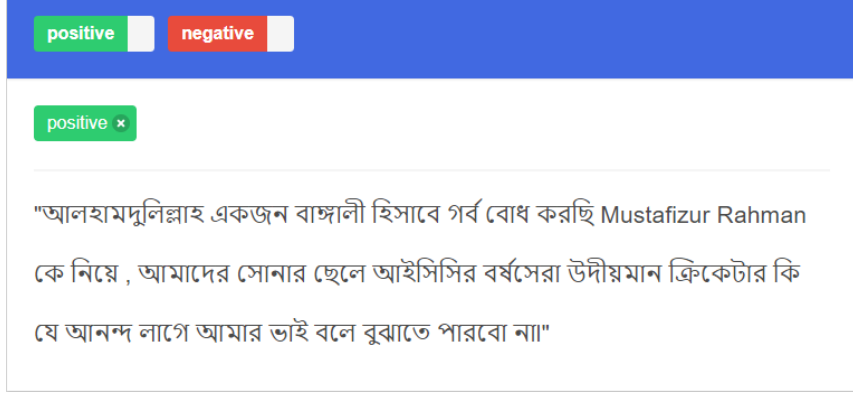
Figure 3. Snapshot of the text annotation tool.